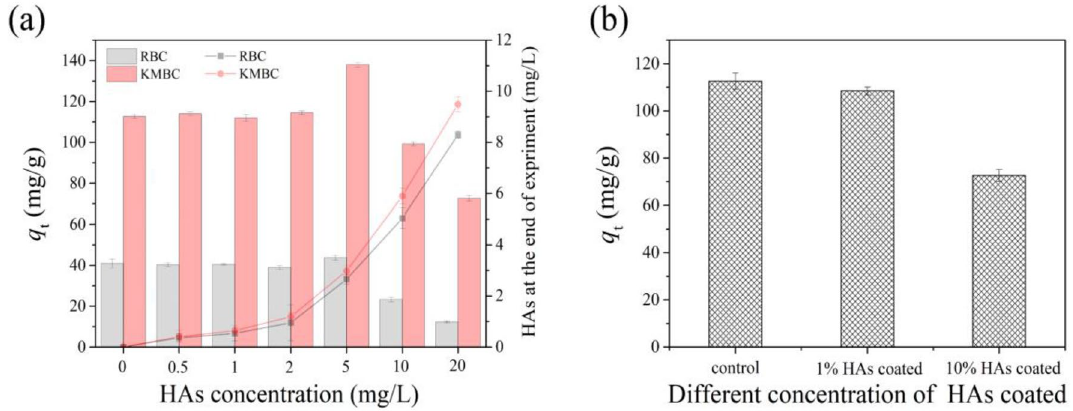
Figure 6. ( a ) Effects of different concentration of dissolved HAs (0–20 mg/L) on TC removal by RBC and KMBC, and the residual of dissolved HAs after reaction; ( b ) TC adsorption by different amount coated HAs modified KMBC. C 0(TC) = 50 mg/L, m / V = 0.1 g/L, t = 26 h, T = 25 °C, pH =